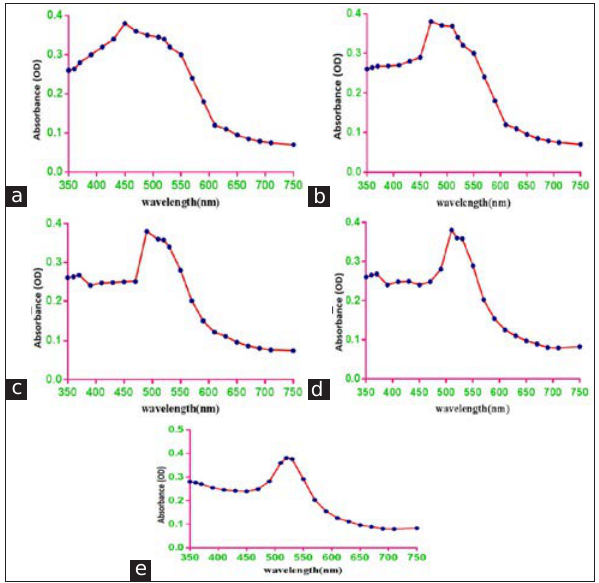
Figure-3: (a) Absorption spectrum of gold nanoparticle (GNP) (using 0.09375% sodium citrate), (b) absorption spectrum of GNP (using 0.1875% sodium citrate), (c) absorption spectrum of GNP (using 0.375% sodium citrate), (d) absorption spectrum of GNP (using 0.75% sodium citrate), (e) absorption spectrum of GNP (using 1.5% sodium